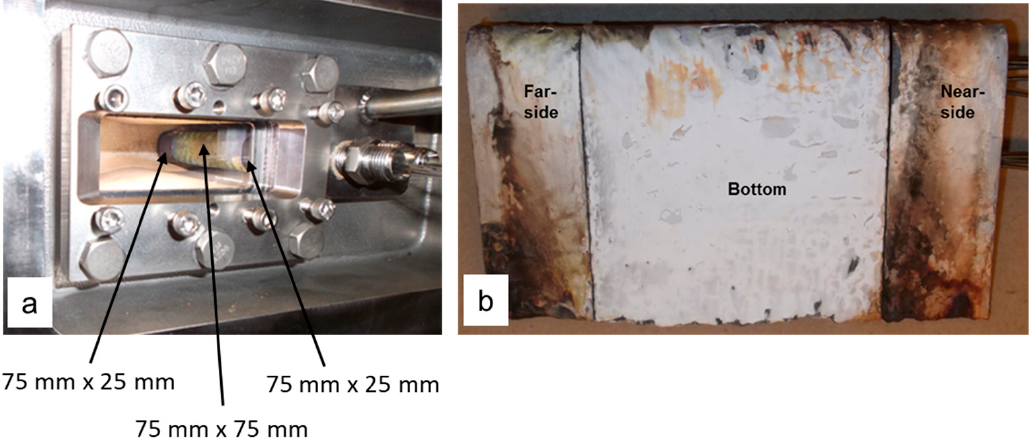
10 of 14 Figure 8. Cross-sections of EBC-coated sintered SiC airfoil after 100 cycles at 1480 °C in air with 1 h hot and 20 min cooling to room temperature per cycle: ( a ) leading edge; ( b ) trailing edge. 3.4. CMC Airfoils (Spin-Dipped EBC) Three EBC-coated CMC airfoils (one 75 mm × 75 mm and two 75 mm × 25 mm) were tested in the Pratt and Whitney high pressure thermal cycling (HPTC) rig. For the 75 mm × 75 mm airfoil, the test temperature and duration were 5 h (50 cycles total) at 1354–1400 °C, followed by 5 h(50 cycles total) at 1354–1432 °C and 5 h(50 cycles total) at 1416–1538